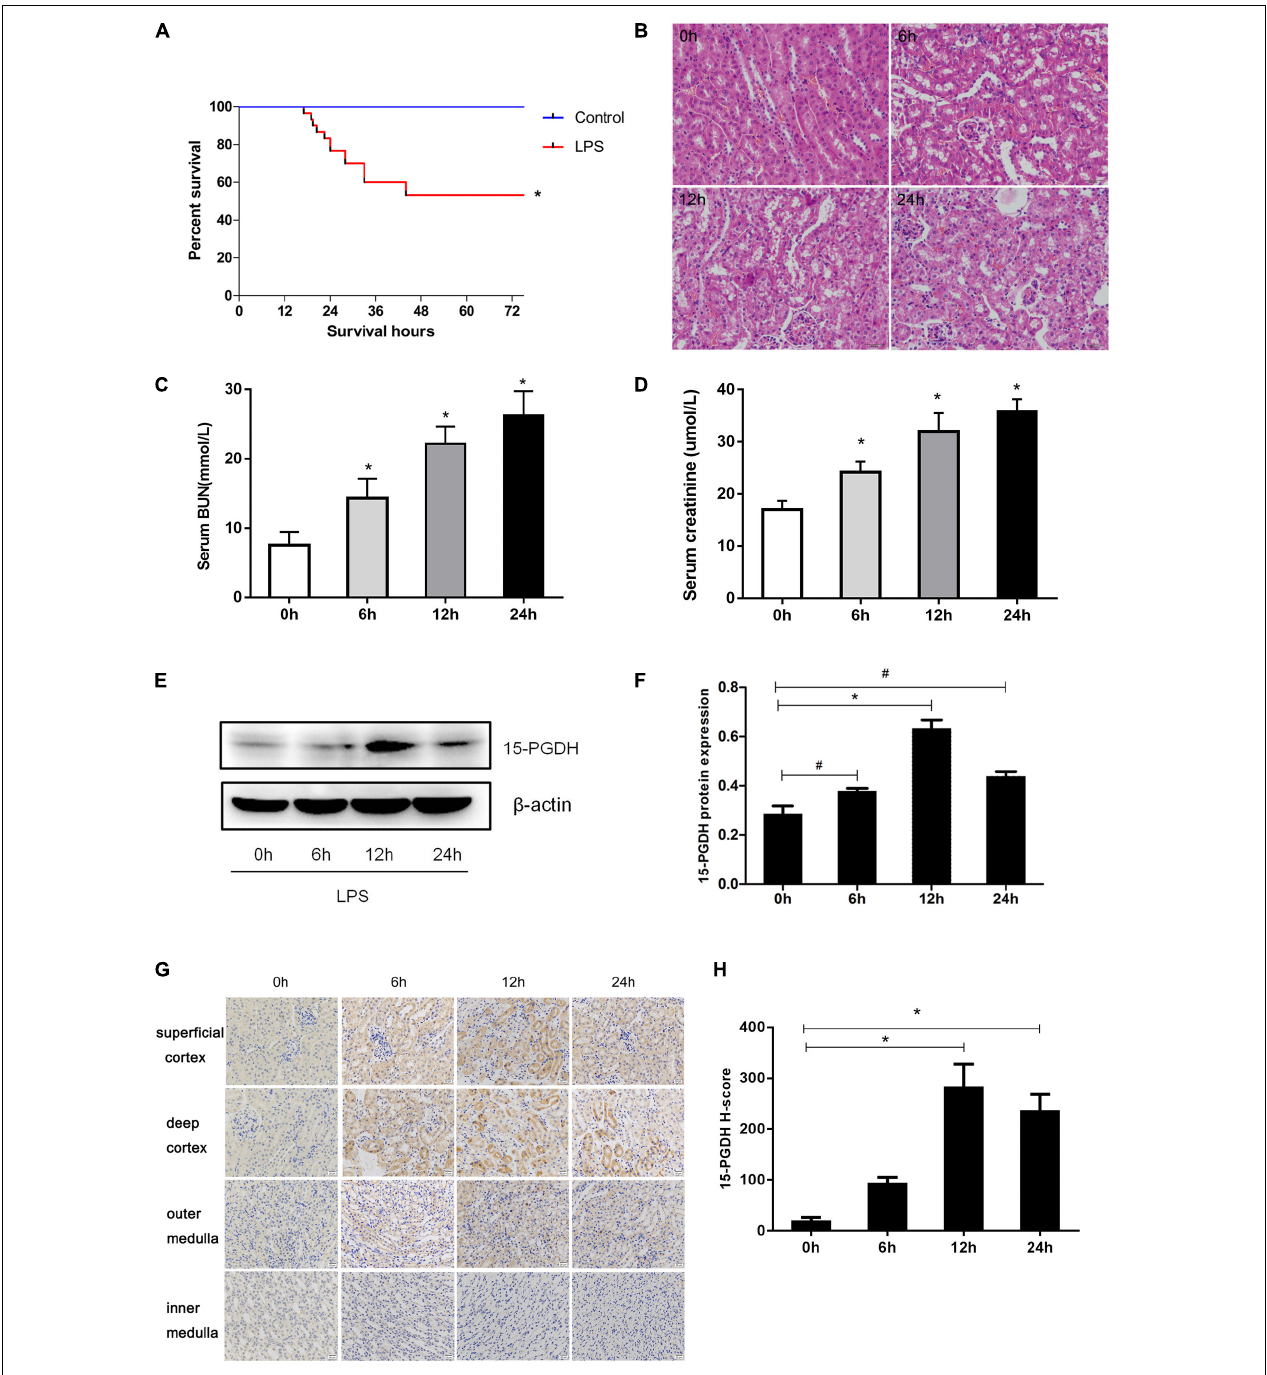
FIGURE 1 | Expression of 15-PGDH in the kidneys of LPS-induced AKI mice model. (A) Effect of LPS on the survival of mice ( n = 30). (B) Effect of LPS on renal morphologic changes of mice (200 × ). (C) The levels of serum urea nitrogen (BUN) were measured at different time points ( n = 6–10). (D) The levels of serum creatinine (Cr) were measured at different time points ( n = 6–10). (E) The expression of 15-PGDH in renal tissues at different time points (0, 6, 12, and 24 h) after LPS (10 mg/kg) stimulation ( n = 3). (F) The signal intensity ratio of 15-PGDH to β -actin in renal tissue ( n = 3). (G) Effect of LPS (10 mg/kg) on the expression of 15-PGDH in mouse kidney tissue (200 × ). (H) Comparison of 15-PGDH IHC H-score after LPS (10 mg/kg) stimulation ( n = 3). Scale = 20 µ m. * P < 0.01 (compared with 0 h), # P < 0.05 (compared with 0 h). Data are mean ± SD.